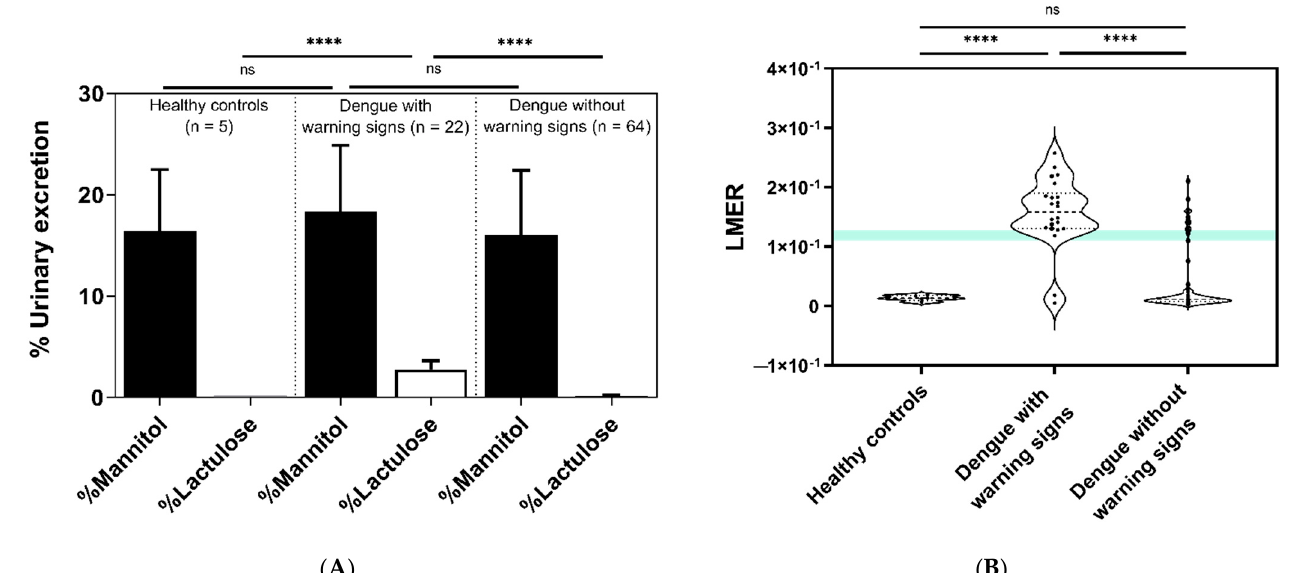
Figure 2. Urinary excretion of mannitol and lactulose from participants among three groups (healthy control subjects ( n = 5) and dengue patients with ( n = 22) or without warning signs ( n = 64)). ( A ) The percentages (%) of urinary mannitol and lactulose excretion demonstrated significantly higher lactulose excretion in dengue patients with warning signs than in those without warning signs, but there was no significant difference in mannitol excretion among the groups. ( B ) Comparisons of the lactulose ‐ to ‐ mannitol excretion ratio (LMER) demonstrated by the violin plot again demonstrated a signif ‐ icantly higher LMER in dengue patients with warning signs than in dengue patients without warning signs (20 from 22 versus 11 from 64 participants). The transverse dotted line demonstrates the median and quartiles. A dot refers to an individual value. The light blue area indicates the 90th percentile of the upper normal limits (0.1187) as a reference and serves as the cutoff value for a positive LMER test. ( **** p < 0 . 0001 and ns stands for nonsignificant. ) Table 2. The outcomes of the intestinal permeability test by using the lactulose ‐ to ‐ mannitol excretion ratio (LMER) strati ‐ fied by warning signs and phases of dengue infection at the time of enrollment ( t = 0). Febrile Phase